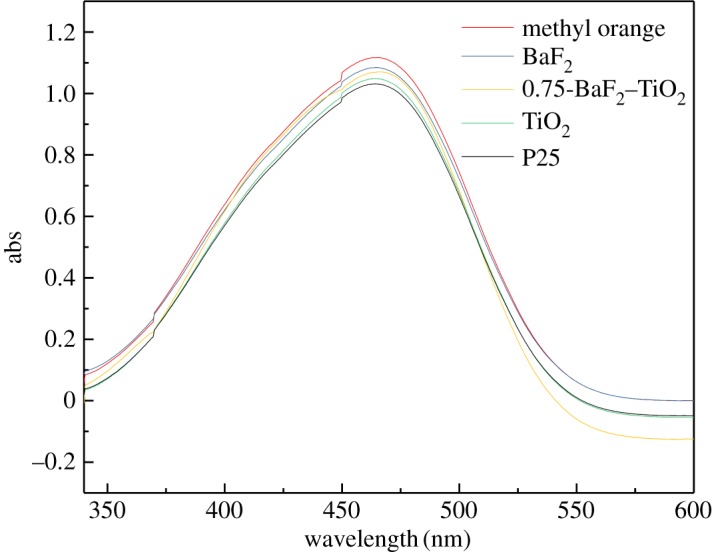
Ultraviolet–visible spectra of methyl orange solution adsorption by the different catalysts (CBaF2, CTiO2, CP25: 1 g l−1; C0.75-BaF2–TiO2: 1.75 g l−1).